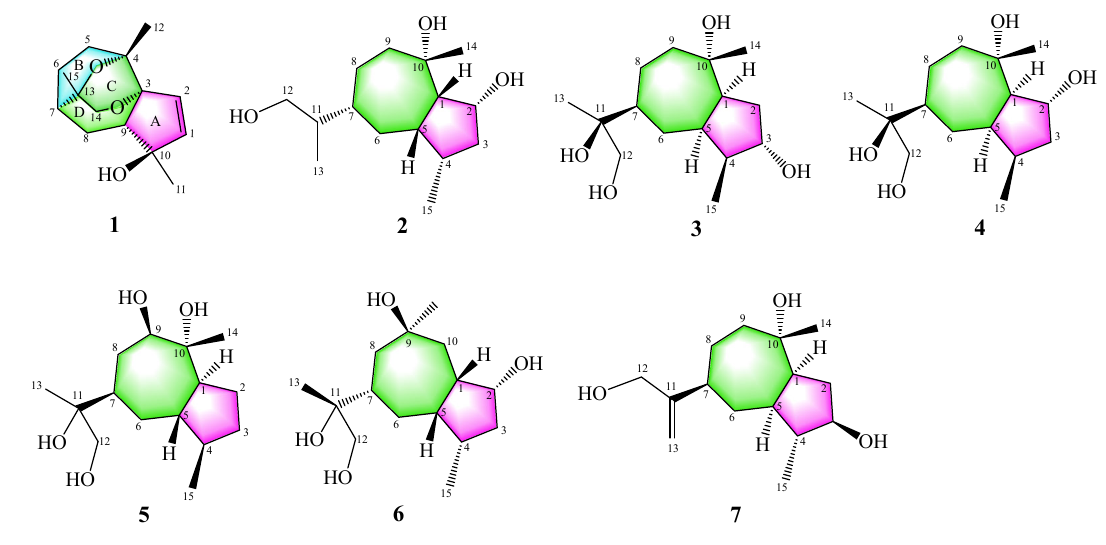
Figure 1. The structures of compounds 1 – 7 .